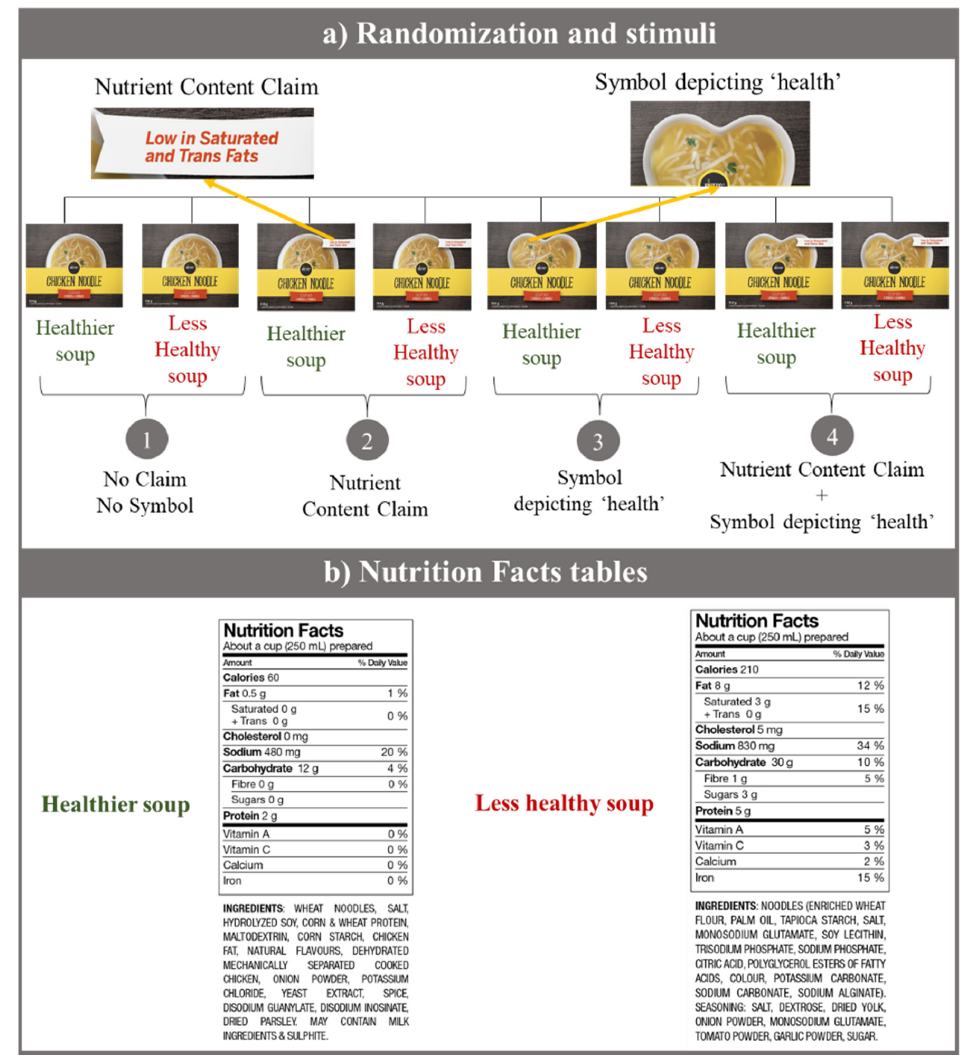
Figure 1. Images of mock labels used in the survey. ( a ) Summary of the eight conditions (2 × 2 × 2 factorial design) used in the survey and the four different labels created. ( b ) Nutrition Facts tables (NFts) for the healthier and less healthy soups. The nutritional quality was determined using the Food Standards Australia New Zealand Nutrient Profiling Scoring Criterion [67] and based on similar products found in the Canadian food